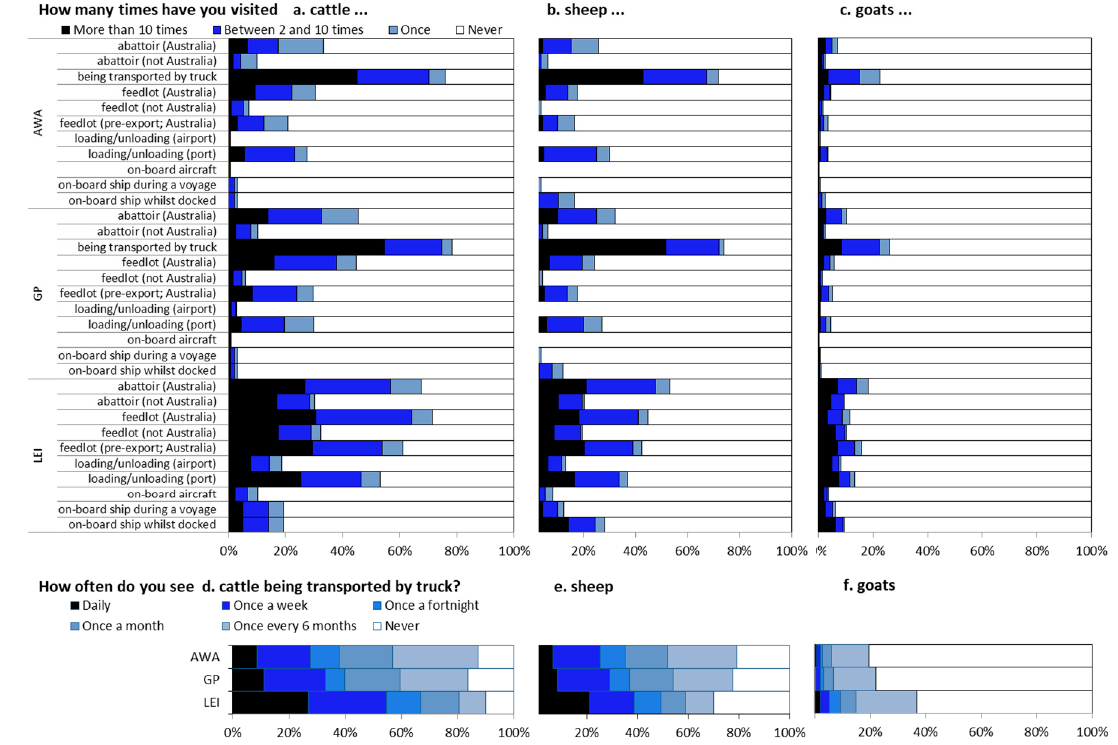
Figure 3. Experiential background of survey respondents grouped into three stakeholder categories: animal welfare advocates (AWAs), general public (GP) or live export industry (LEI) workers.